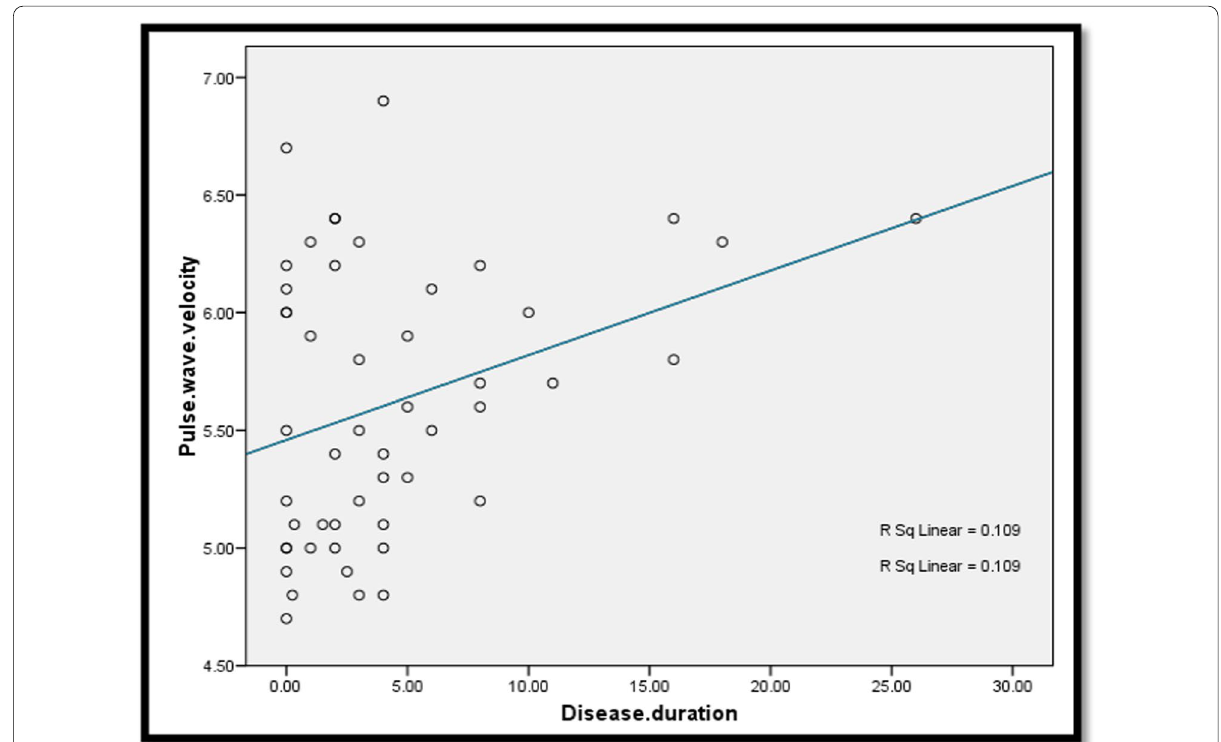
Fig. 1 Correlation between disease duration (years) and peripheral PWV (m/s). PWV, pulse wave velocity